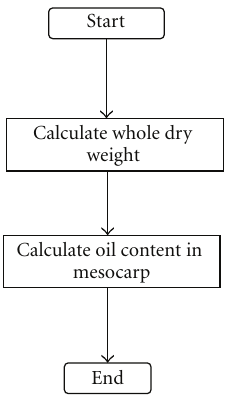
Figure 3: Flow chart for calculating oil content.